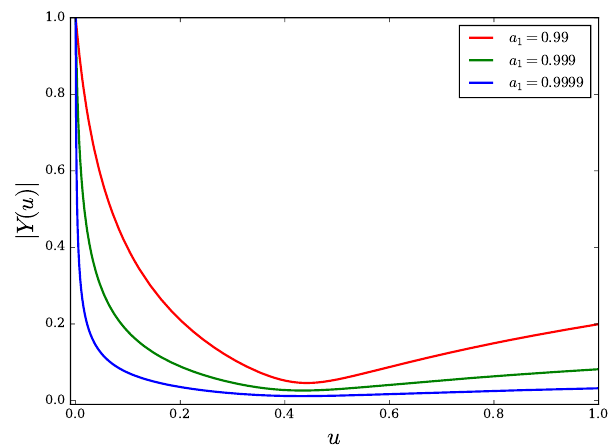
Figure 2 . Numerical eigenfunctions of the angular equation (2.31) for di(cid:11)erent values of a 1 . These were obtained by matching the Frobenius expansion at two of the singular points, u = 0 and u = u 0 , with 16 terms. The values of (cid:22) were chosen by requiring consistency with the radial